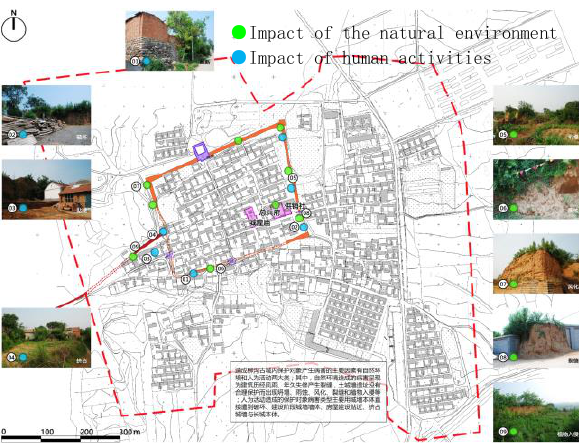
Figure 4. Influencing factors to the earthen